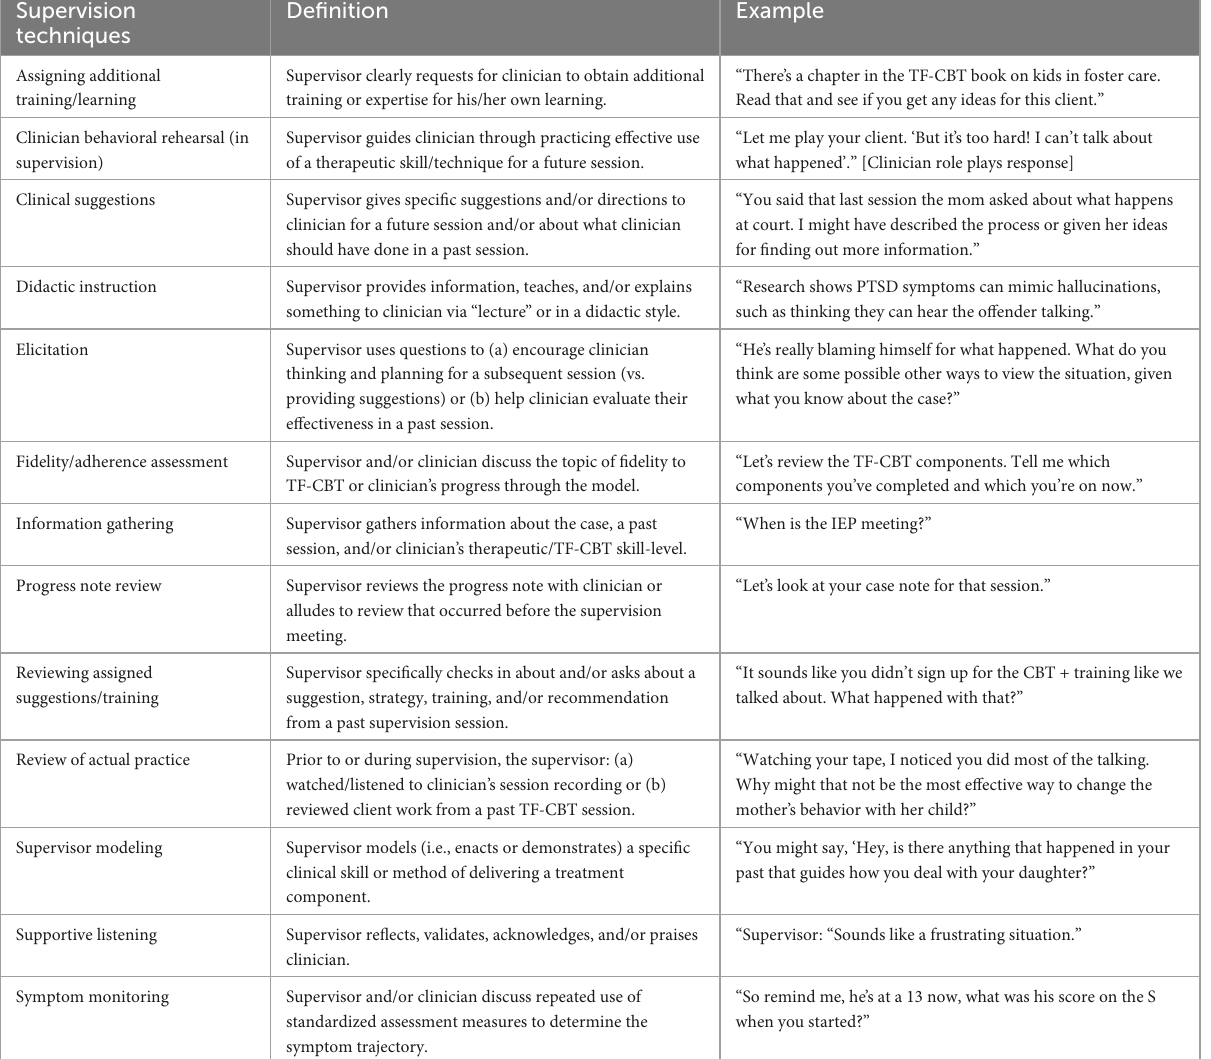
TABLE 2 Supervision techniques, definitions and